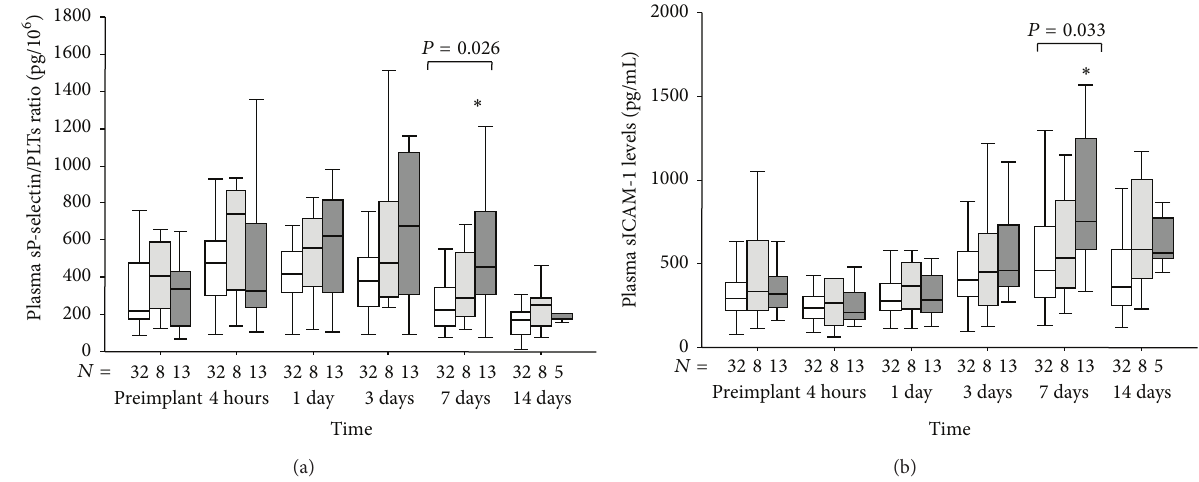
Figure 4: (a) Time course of plasma sP-selectin normalized by platelet (PLT) count and (b) sICAM-1 levels in patients with postoperative maximal tSOFA score < 11 (group A: empty box-plots), and patients with postoperative maximal tSOFA score ≥ 11 and positive (group B: light gray box-plots) or negative (group C: dark gray box-plots) 3-month outcome. 𝑃 values are for differences among groups at each time-point by Kruskall-Wallis text. ∗ 𝑃 < 0.05 versus group A by Mann-Whitney text corrected by Bonferroni. ∘ 𝑃 < 0.05 versus group B by Mann-Whitney text corrected by